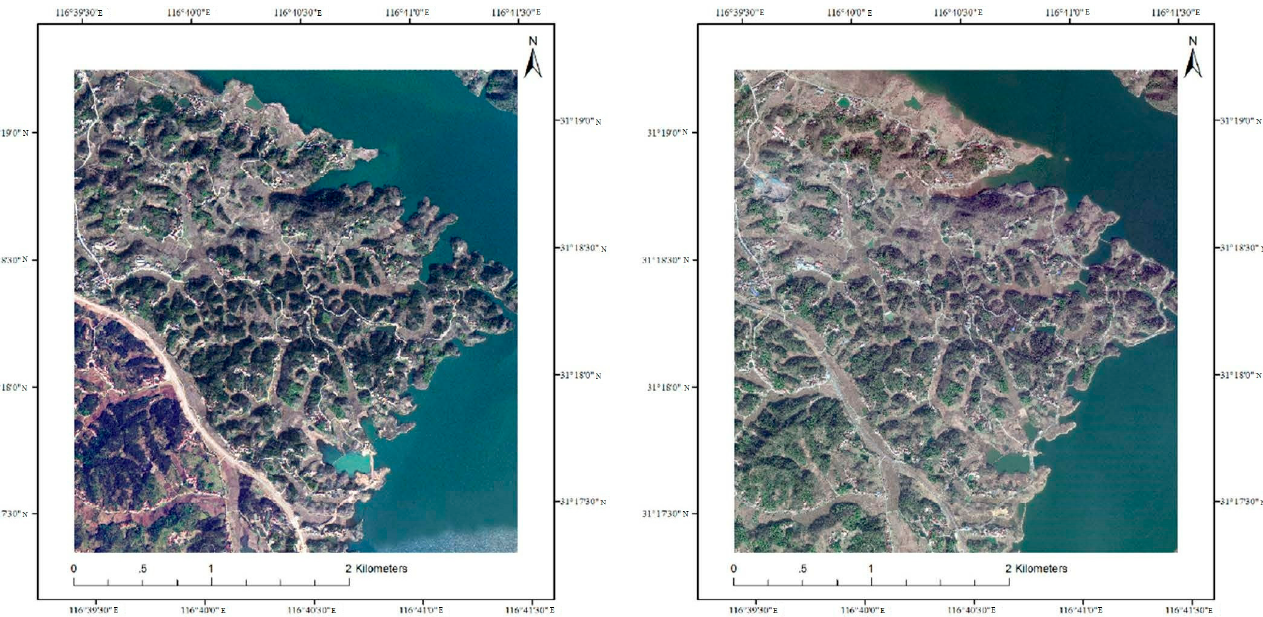
Figure 5. Data of sample area.